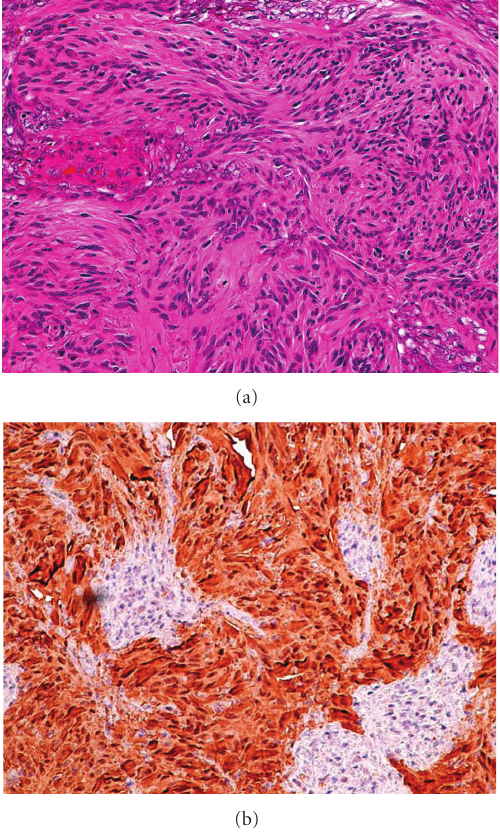
Figure 3: (a) The tumor cells arranged in fascicular and nodular pattern. (b) S-100 Protein [+]. The tumor cells illustrate strong immunoreactivity to S-100